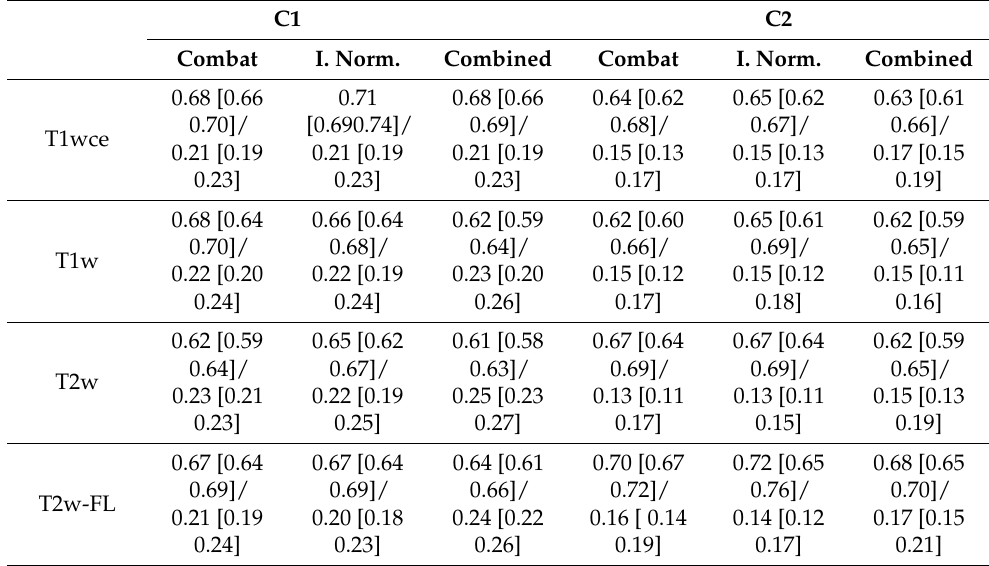
Table 5. Performance of the top-ranked image normalization method separate and in combination with the feature-based method Combat for cohort C1 and C2 for each MR sequence. The average (across all bin counts) 10-CV C-I/MSE with 95% confidence intervals are reported. C1 C2 Combat I. Norm. Combined Combat I. Norm. Combined 0.68 T1wce